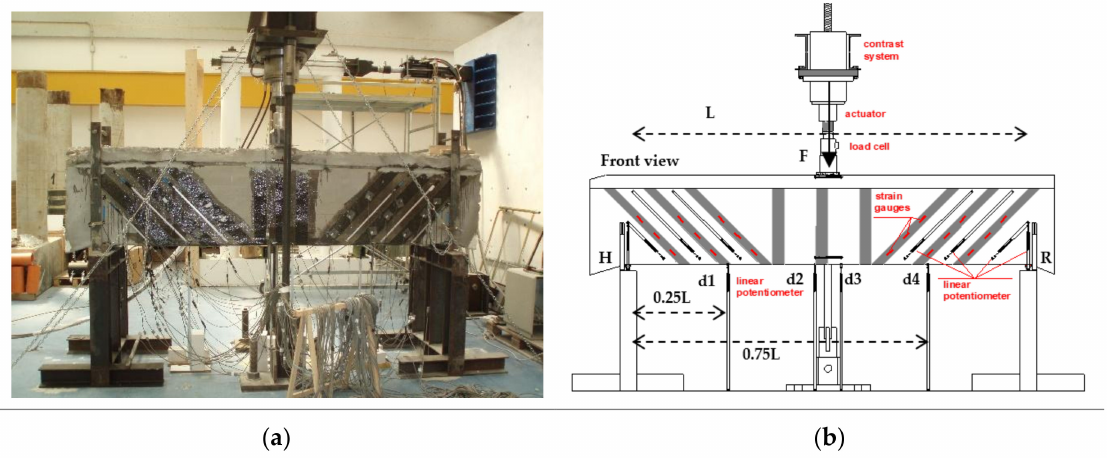
Figure 5. Three-points loading test apparatus: ( a ) photo and ( b ) scheme of the system to apply the loads and to measure deformation of the beam and strain of the CFRP U-strips (frontal